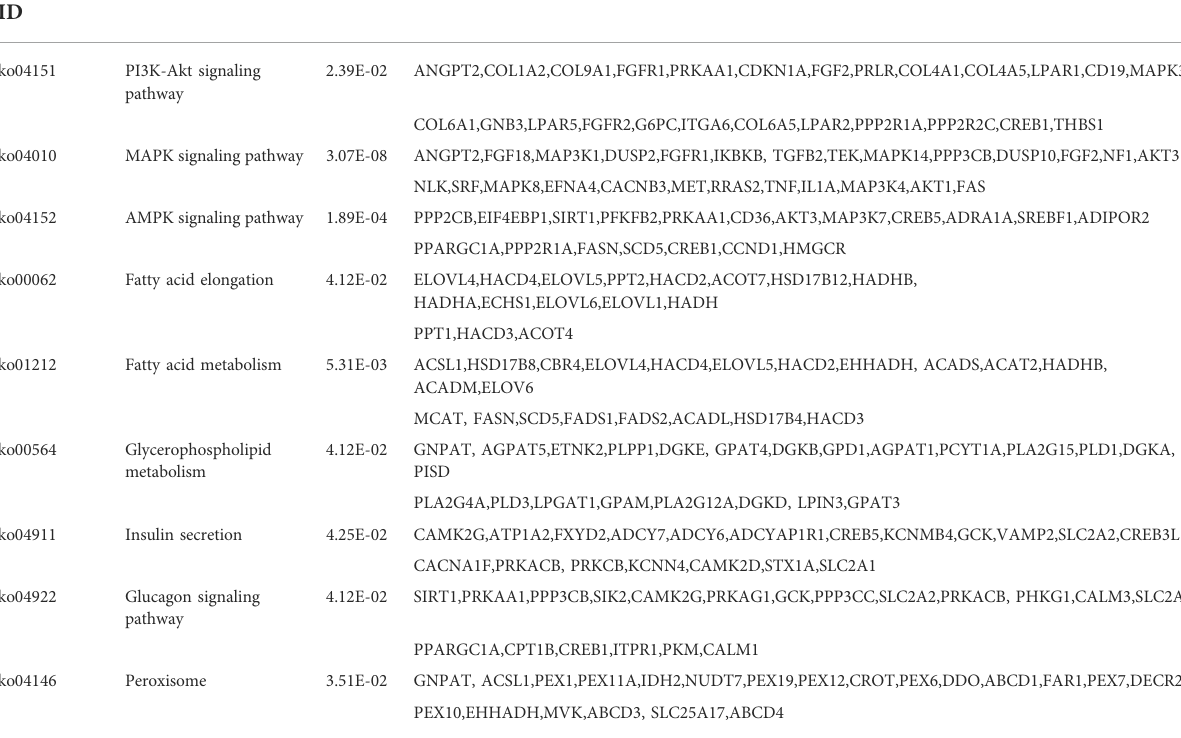
TABLE 2 Nine signi fi cantly enriched pathways related to lipid